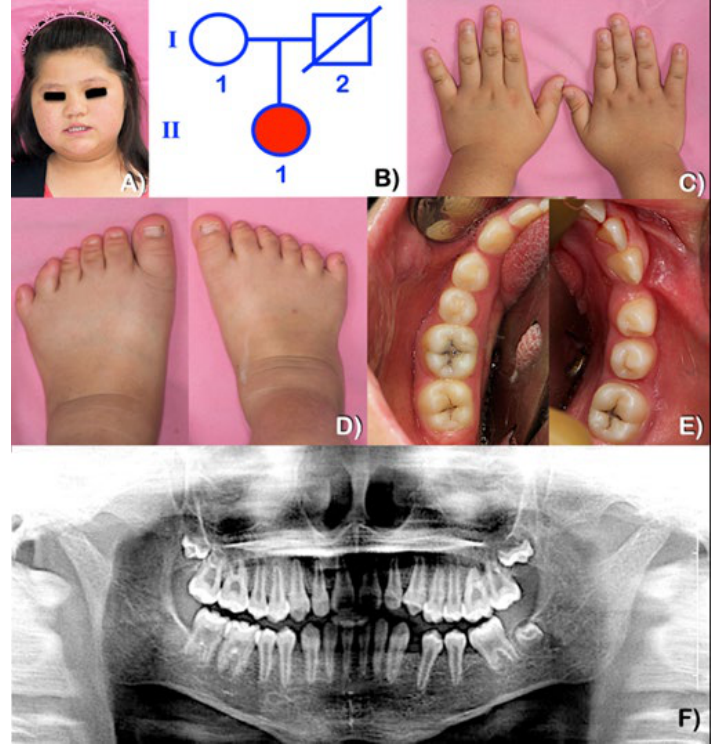
Figure 3. Patient 3 at age 12 years has Bardet–Biedl syndrome caused by digenic triallelic mutation in BBS2 and BBS7 . ( A ) Obesity. ( B ) Pedigree. ( C ) Small fingernails. ( D ) Post-axial polydactyly of the feet. Note small toenails. ( E ) Microdontia of the mandibular premolars. Note the dental caries on the permanent molars. ( F ) Panoramic radiograph showed the absence of the mandibular left